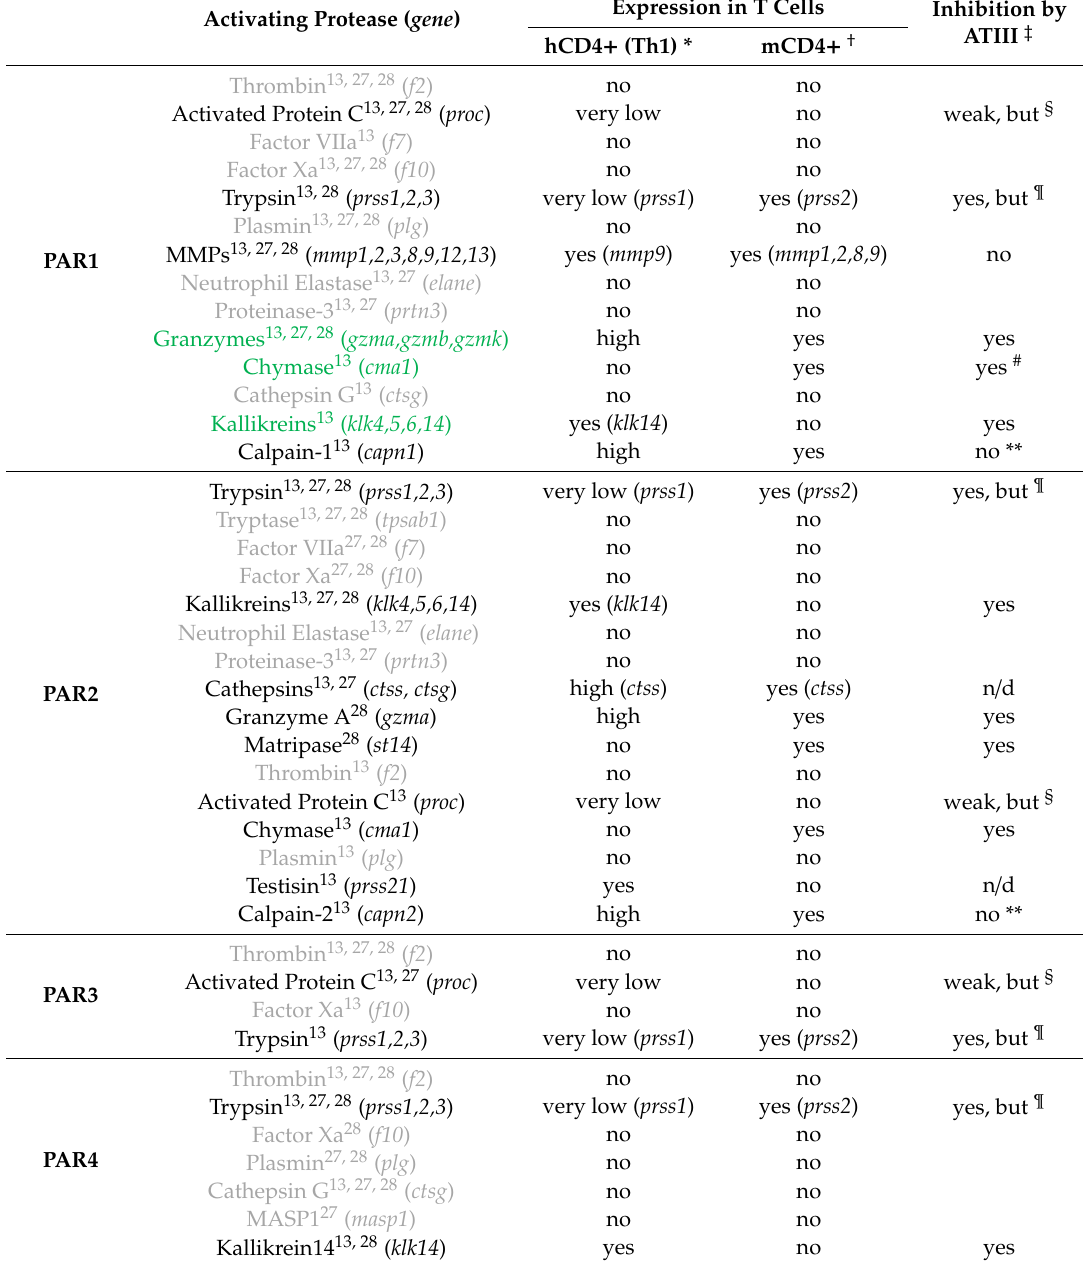
Table 1. Literature was searched for expression of PAR1-4 activating proteases in CD4 + cells as well as their inhibition by ATIII. Proteases, for which no evidence of CD4 + cell expression could be found, are in grey. Note that AT III inhibited PAS TEM (Figure 1B). Thus, only CD4 + expressed proteases that are sensitive to AT III are likely candidates of PAR activation in PAS-GPNT co-cultures. For PAR1 activating proteases, only granzymes, chymase and kallikreins (highlighted in green) fitted these criteria. Expression in T Cells Inhibition Activating Protease ( gene )